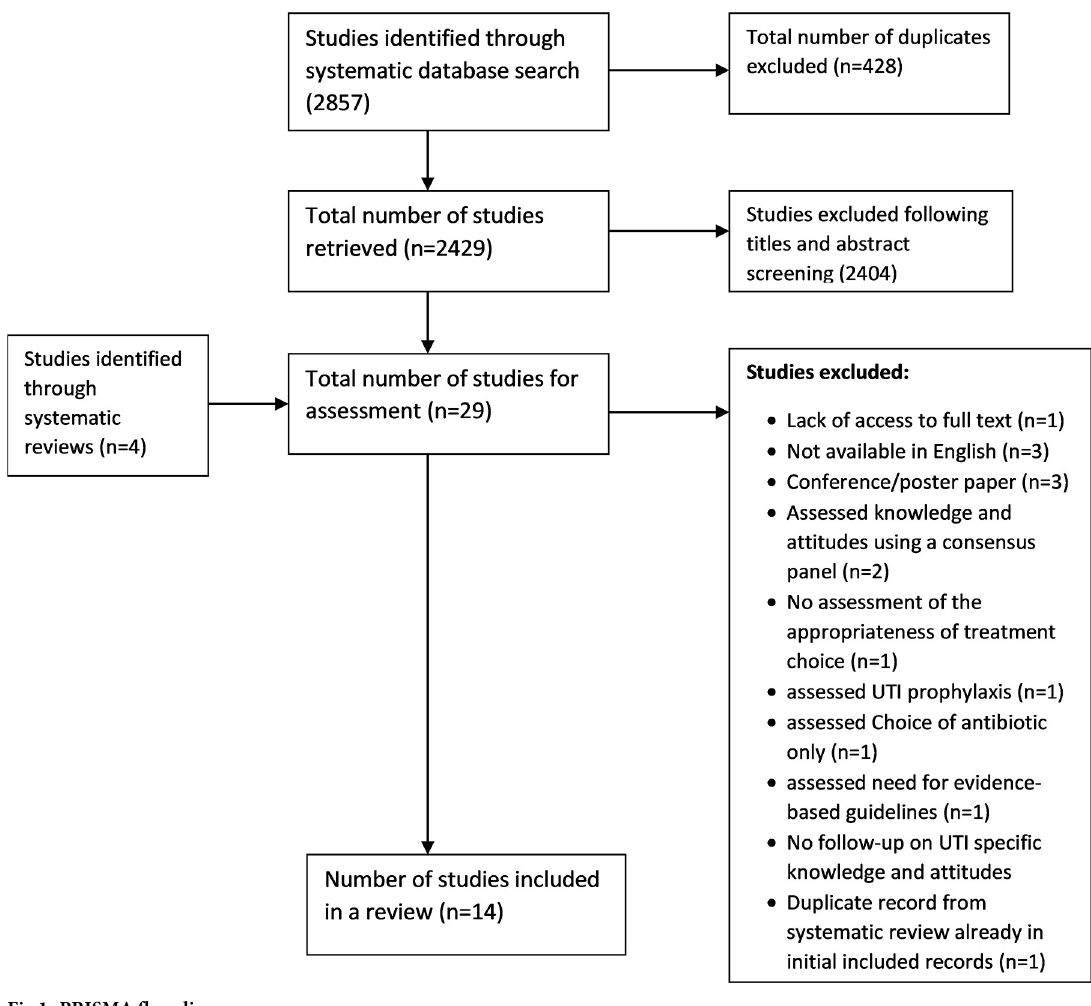
Fig 1. PRISMA flow